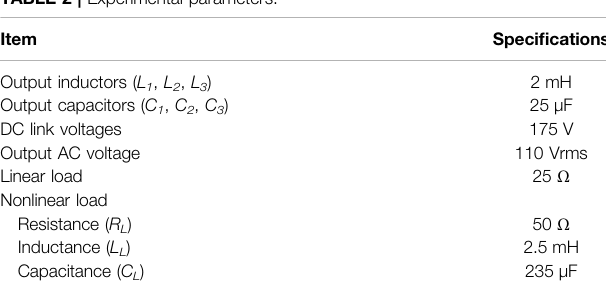
TABLE 2 | Experimental